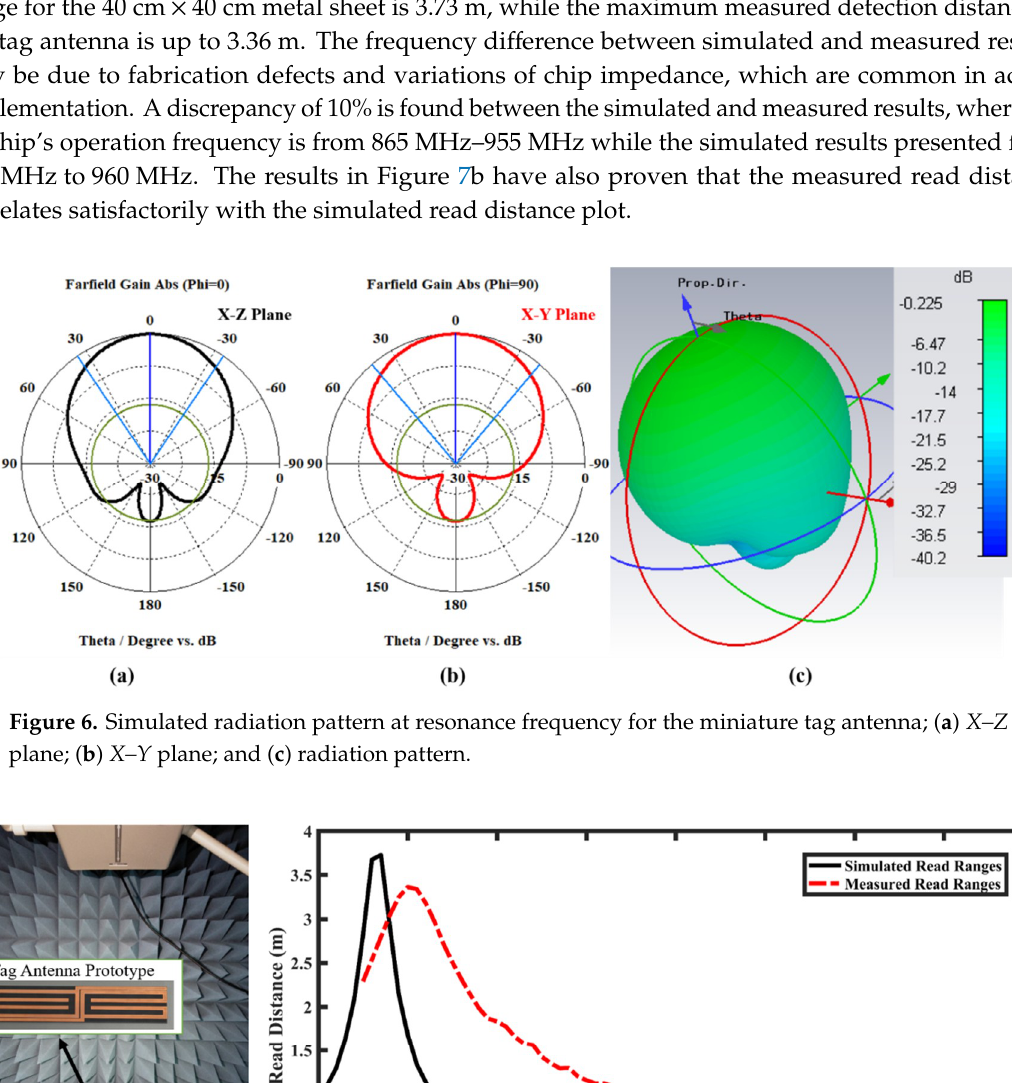
Figure 7. ( a ) the measurement setup; ( b ) the computed and measured detection distances.